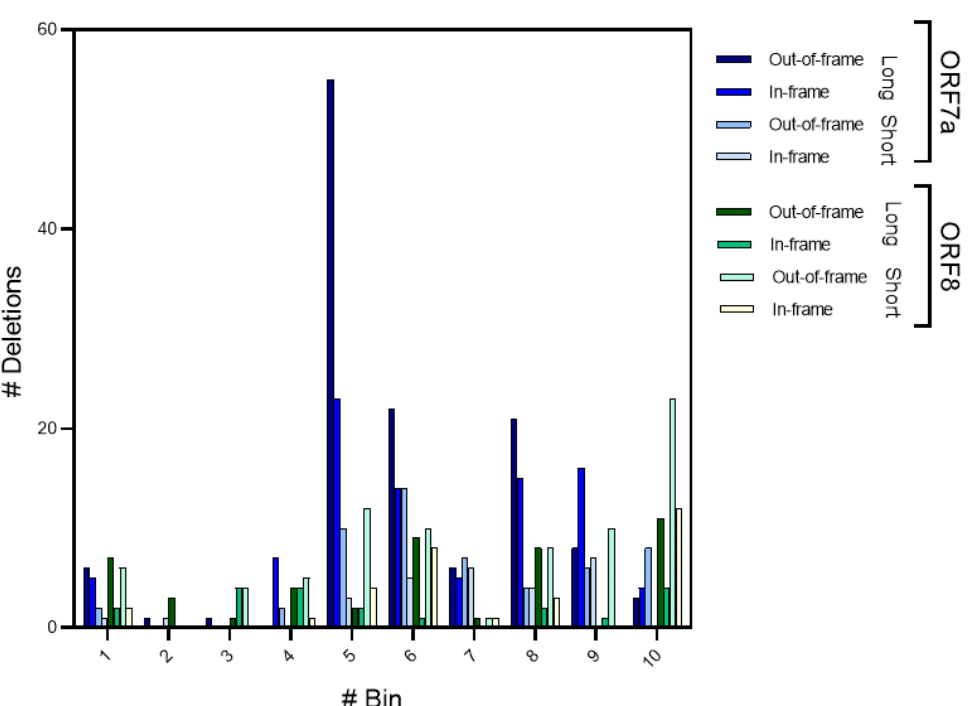
Figure 6. Distribution of deletions across the ORF7a and ORF8 genes. The difference between out- of-frame and in-frame long deletions in ORF7a is statistically significant: p = 0.003 according to the 2 × 10 exact test. Heatmap of the distribution of in- and out-of-frame deletions in UTR and CDS for each bin (1 to 10) is shown in the Figure S7.